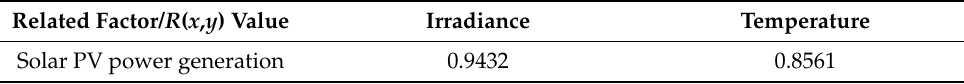
Table 3. Correlation analyses of solar PV power generation with respect to irradiance and tempera-